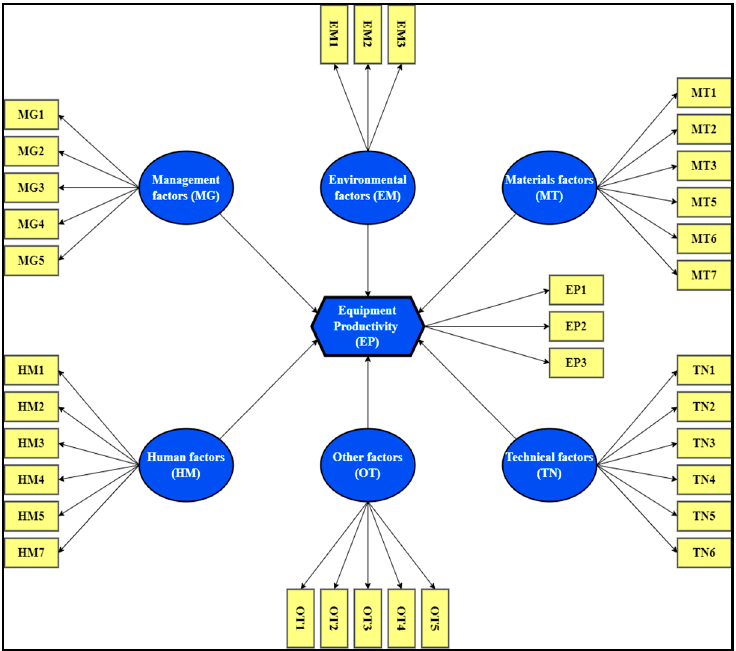
Figure 3. Modified framework using SEM.